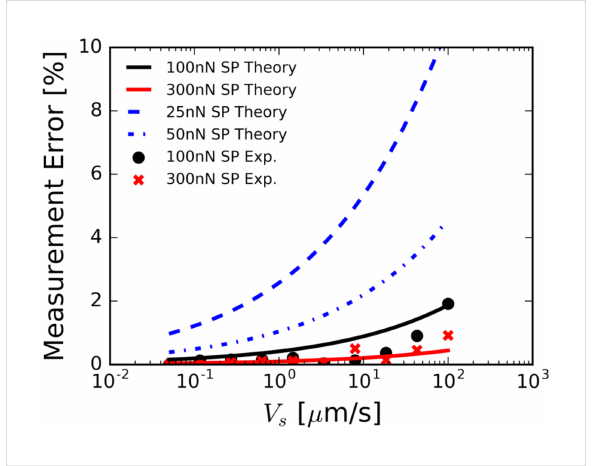
Figure 5: Measurement error introduced by the scan speed phenome- non. Black circles and red crosses represent the percent error in measured sample stiffness on mica as compared with the stationary measurement (for 100 and 300 nN force set-point (SP), respectively). The black and red lines represent the percent error calculated by the lubrication theory given in Equation 3 and Equation 4. The percent error was calculated using the measured stationary sample stiffness of mica ( k s = 350 N/m) and the equation for the effective sample stiffness k eff . The blue dashed line represents the theoretical percent error for a force set-point of 25 nN. The blue dashed and dotted line represents the theoretical percent error for a force set-point of 50